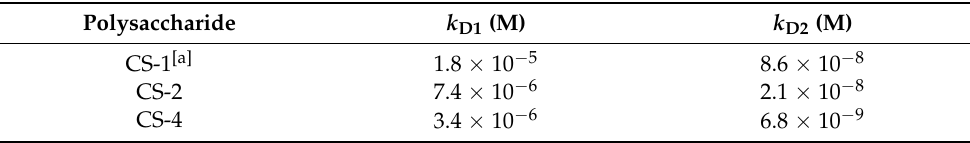
Table 3. Thermodynamic data of marine CSs-FGF-2